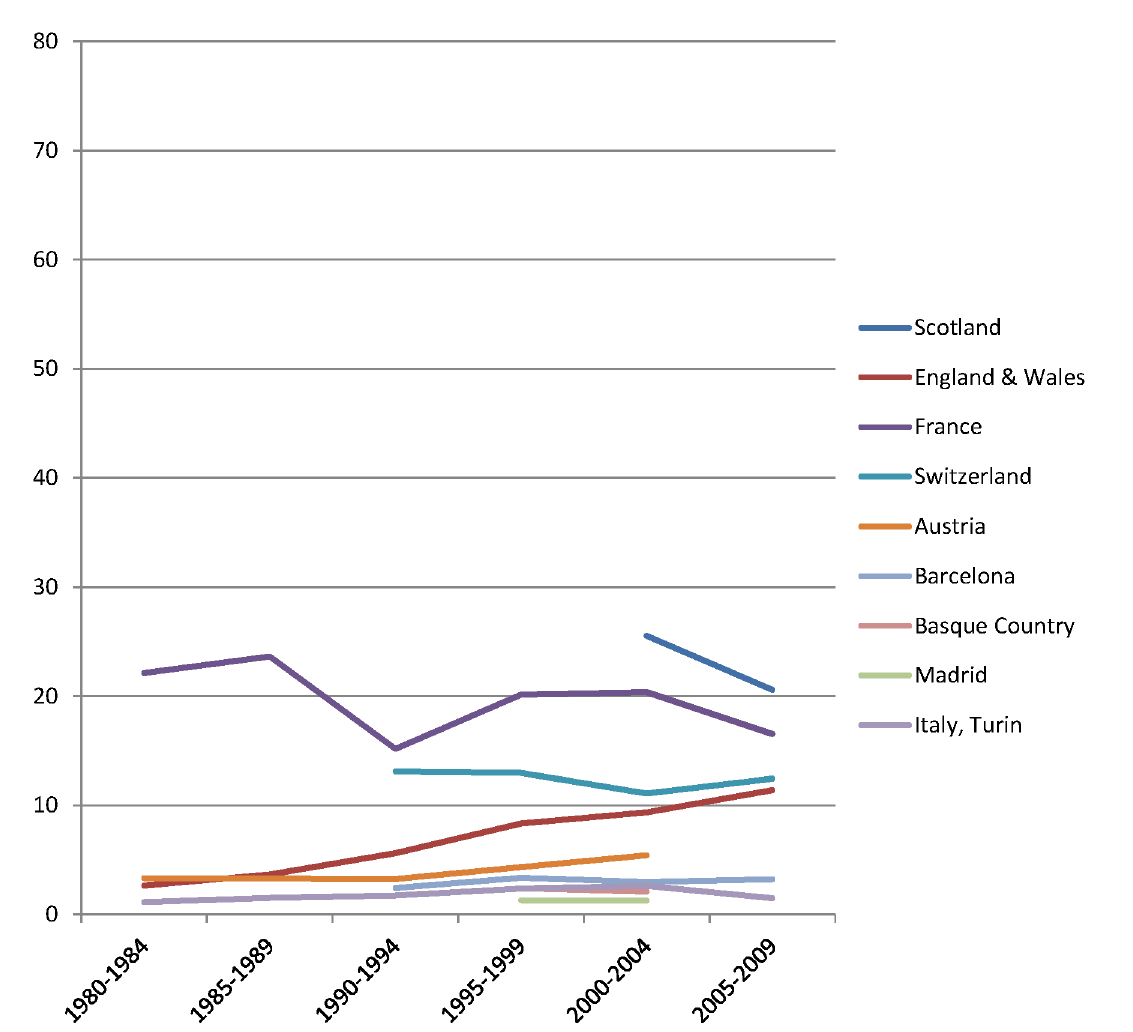
Fig 10. Trends in age-adjusted mortality from alcohol-related causes among women aged 35 – 79 y in the low education group in Western and Southern European countries/regions, ca. 1980 – 2010, by country/region. The y- axis shows age-adjusted alcohol-related mortality in deaths per 100,000 person-years. In England and Wales, individuals in the low and middle education groups could not be distinguished before 2000, and therefore both groups have been combined in the low education group in all study